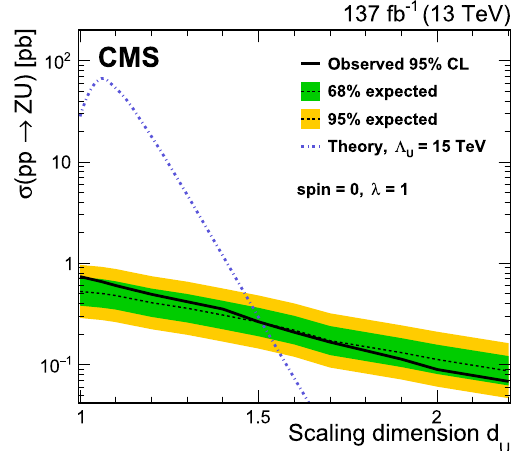
Fig. 10 The 95% CL upper limits on unparticle+Z production cross section, as a function of the scaling dimension d U . These limits apply to fixed values of the effective cutoff scale Λ U = 15TeV and coupling λ = 1